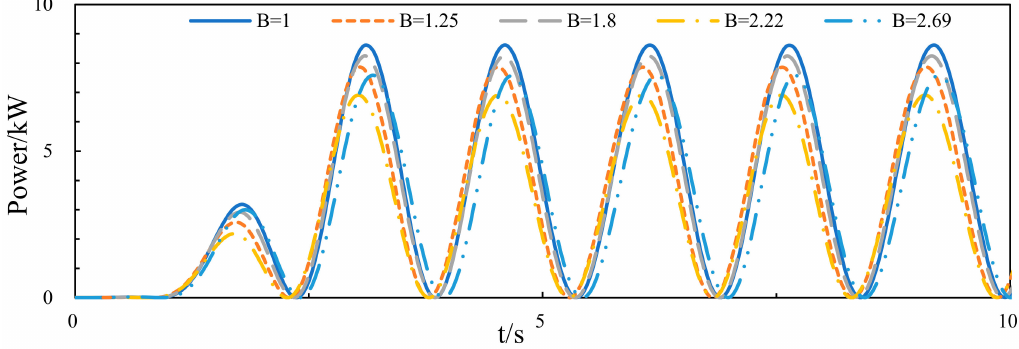
Figure 6. The instantaneous power curves of Buoy